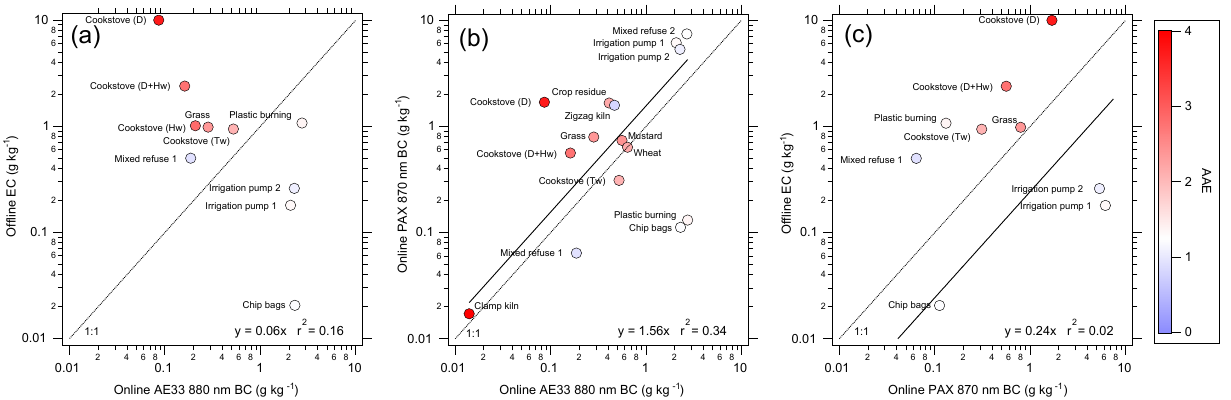
Figure 7. Scatter plots of (a) off-line thermal–optical-measured elemental carbon emission factors from Jayarathne et al. (2018); (b) online PAX 870nm measured black carbon emission factors from Stockwell et al. (2016) vs. online AE33 aethalometer 880nm measured black carbon emission factors in units of gkg of fuel − 1 . Panel (c) provides a scatter plot of the off-line EC measurements vs. the online PAX 870nm measurements. Linear regression curves are displayed as solid lines with the resulting equation and correlation coefficient displayed in each respective panel. Markers are colored by the AAE for each emission source. Cookstove fuel types are hardwood (Hw), dung (D), and sticks and twigs (Tw). The 1 : 1 lines (dotted) are shown in each plot for